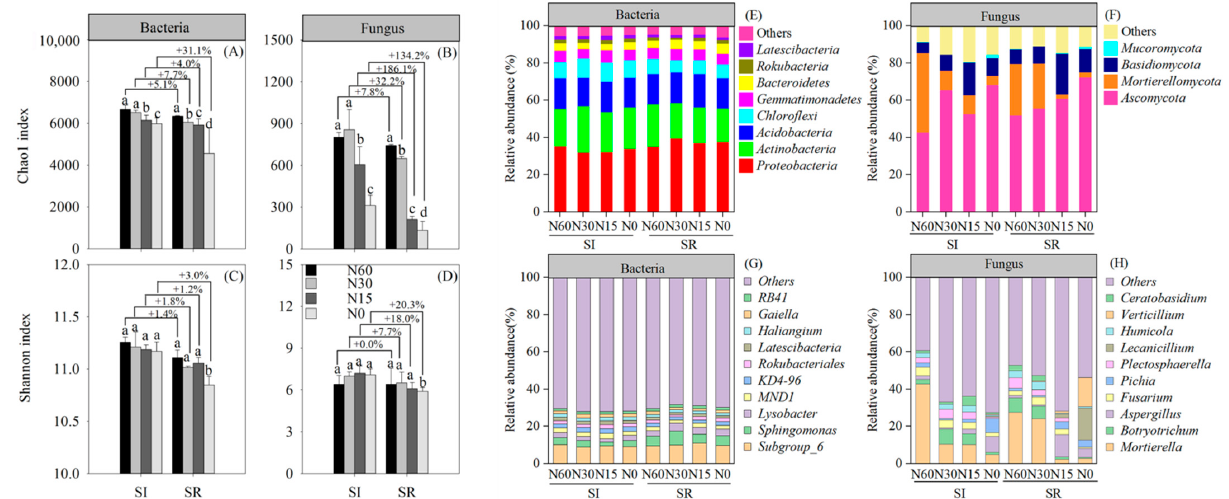
Figure 9. Soil microbial diversity and community composition at the full maturity stage of soybean.